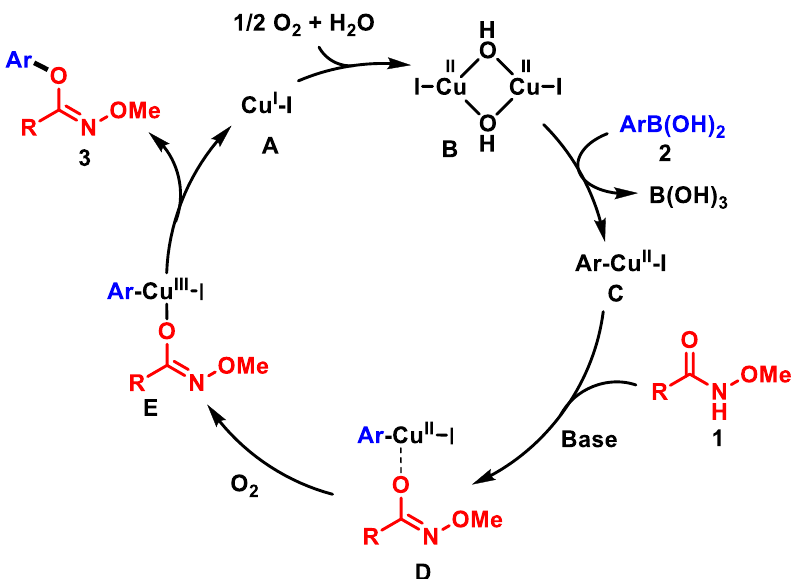
Figure 1. Plausible mechanism of the copper-catalyzed C-O coupling reaction.